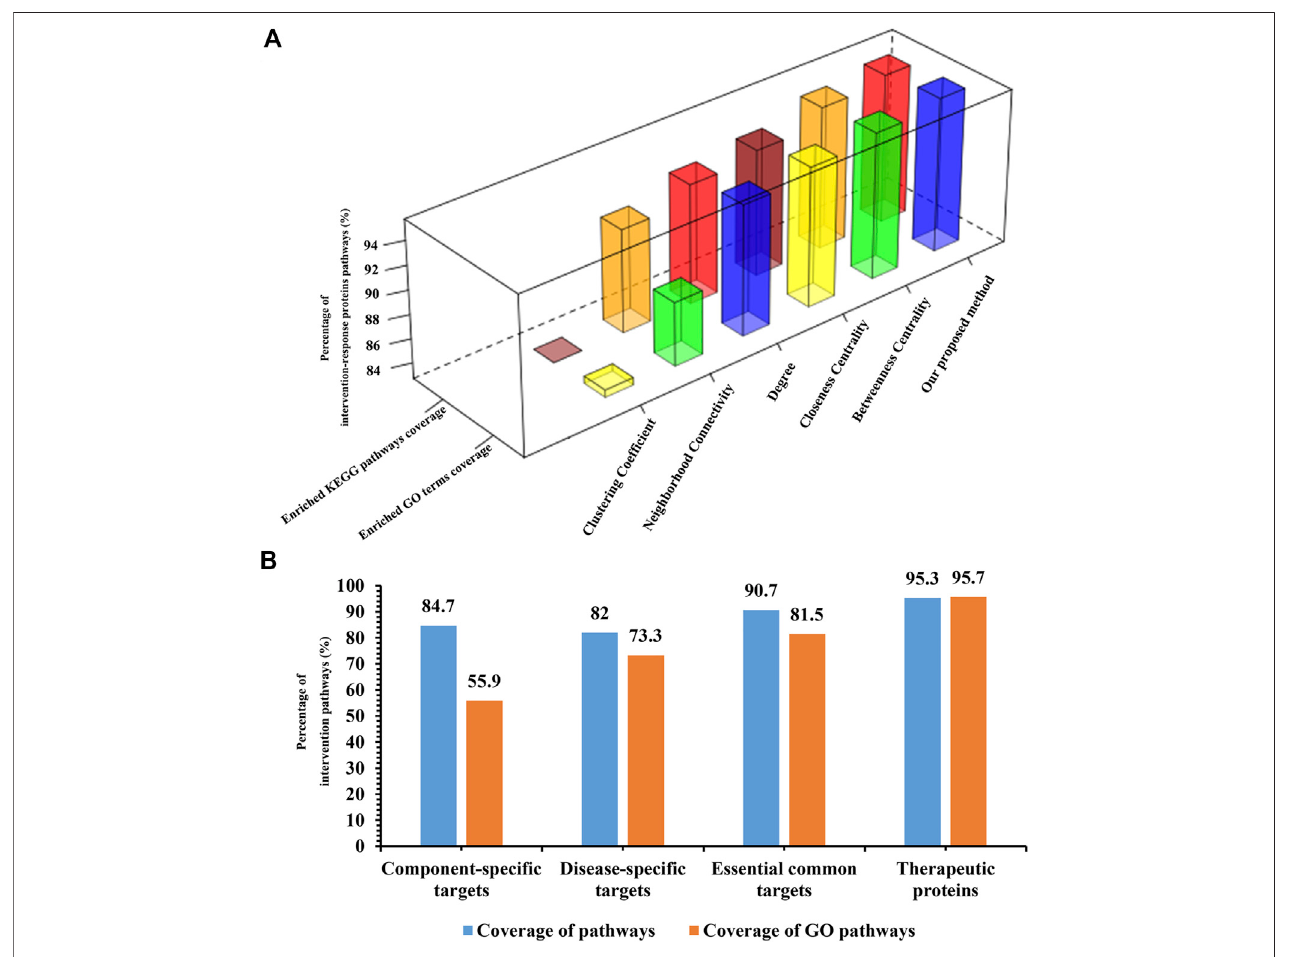
FIGURE 4 | Validation of effective intervention space. (A) : Compare our proposed methods with other widely used methods. (B) : The proportion histogram of component-speci fi c targets, disease-speci fi c targets, essential common targets, and therapeutic proteins in common enriched pathways and GO terms.